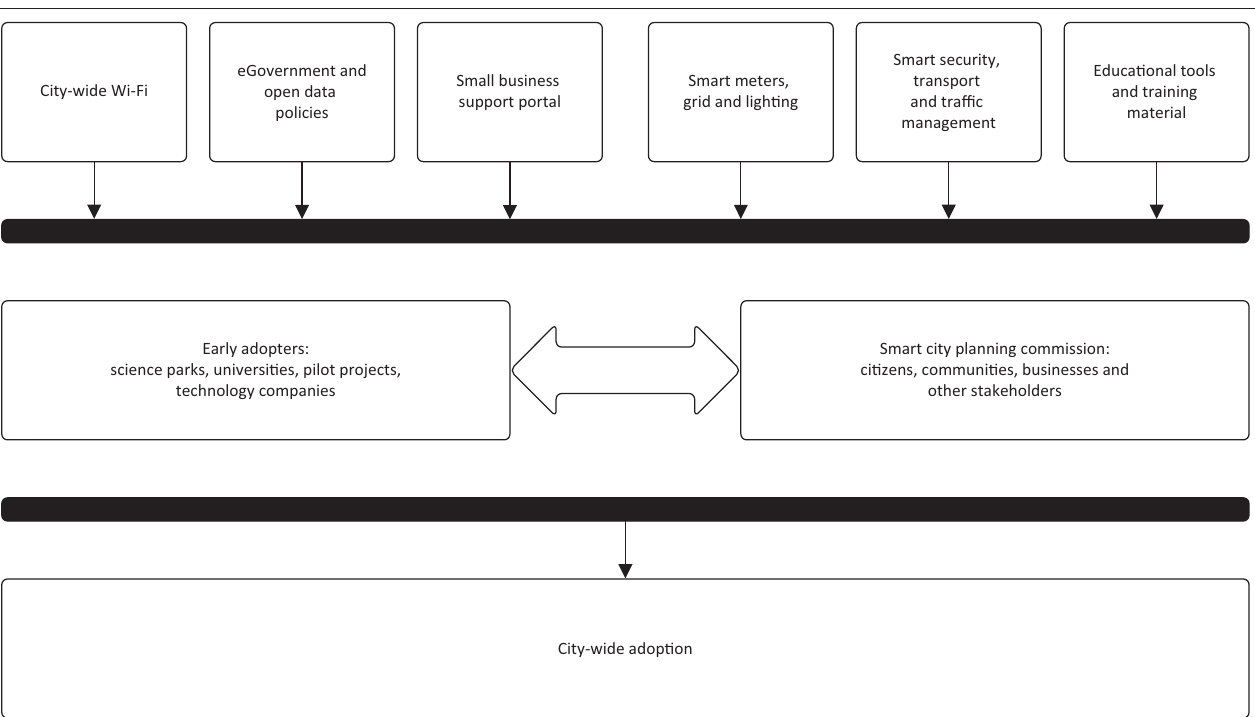
FIGURE 1: A potential smart city development